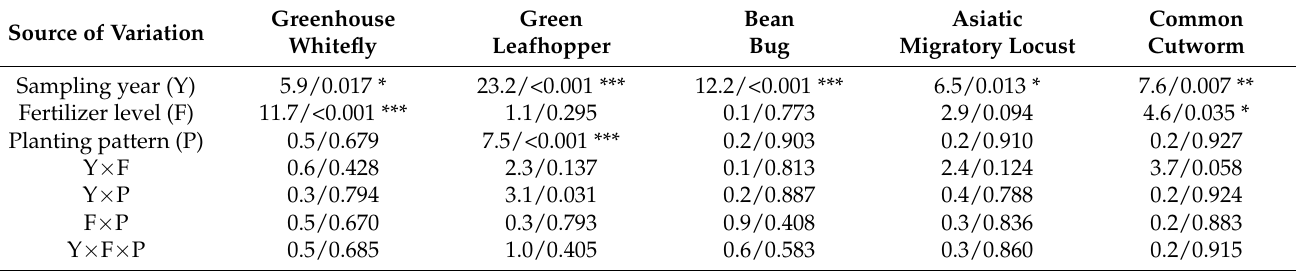
Table 7. Three-way repeated-measure analysis of variance (ANOVA) on the effects of sampling years (Y; 2018 vs. 2019), fertilizer levels (F; normal vs. reduced), intercropping planting patterns (P; sole-crop soybean and three intercropping planting patterns of soybean intercropping with corn) and their bi-/tri-interactions on five major pests in terms of quantity on soybean plants ( F / p